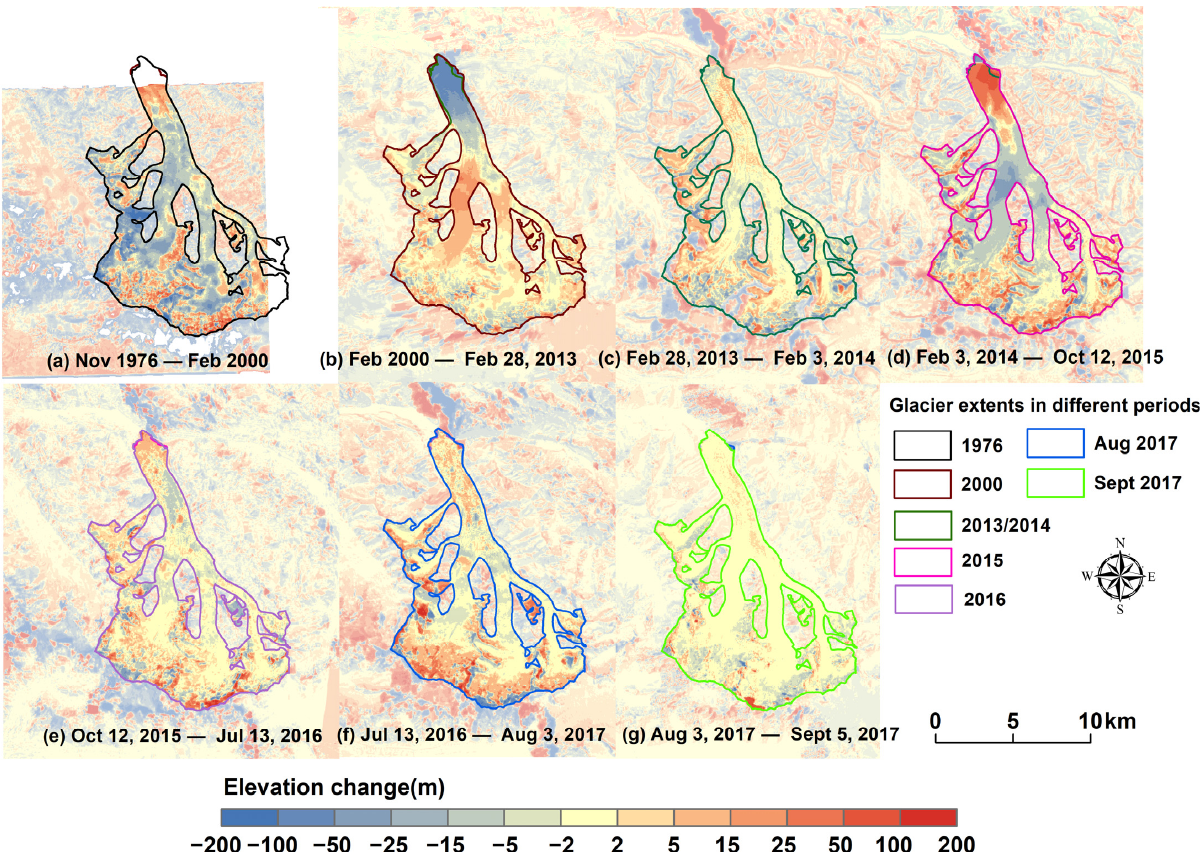
Figure 9. Glacier elevation changes in di ff erent periods.